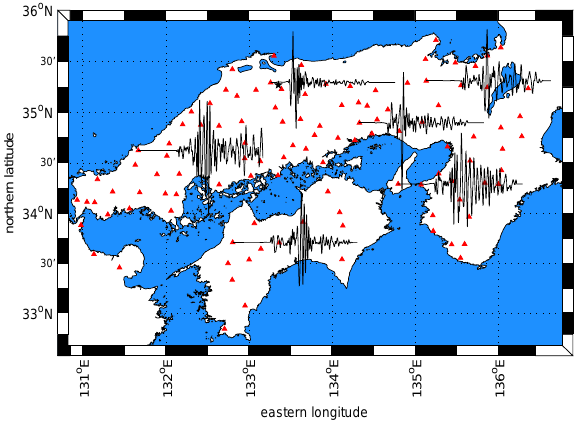
Fig. 13. Time evolution of the normalised S V = R volume V that extends 20km by 20km around the epicentre as es- timated from the time-reversal images from Fig. 12. The peak oc- curs at + 3s relative to the focal time estimated by Semmane (2005) ( t =